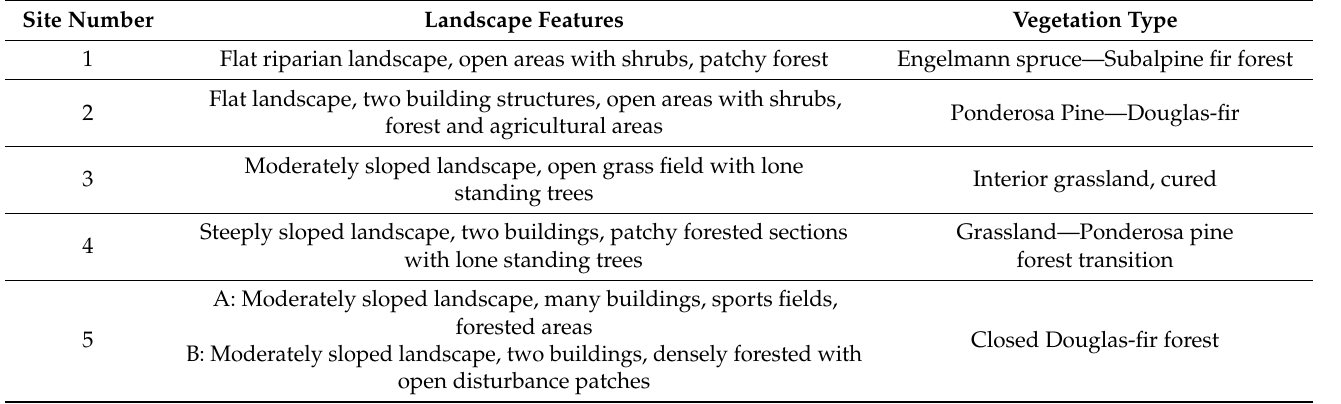
Figure 3. The location of the fire sites used in this study in British Columbia. Table 2. Study Site descriptions, including landscape features and vegetation